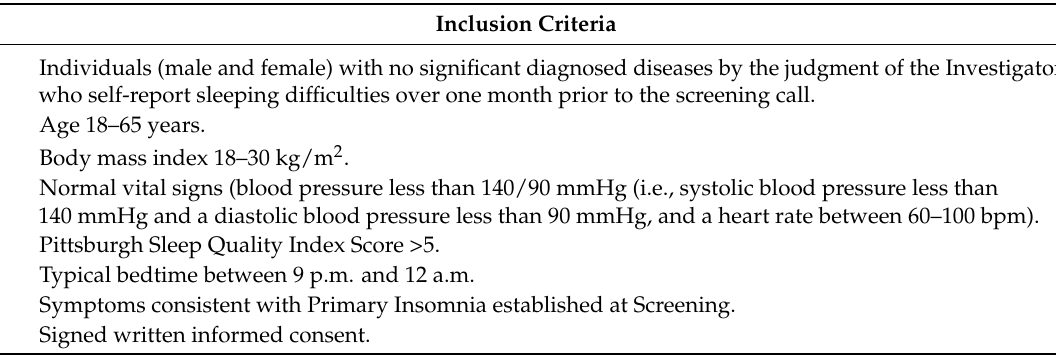
Table A1. Participant inclusion and exclusion